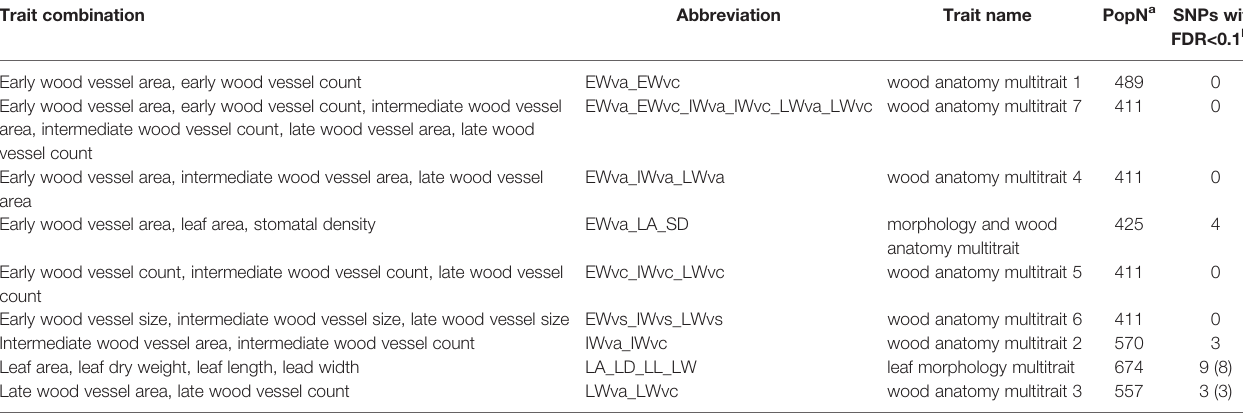
TABLE 2 | List of traits used for multitrait associations and signi fi cant SNPs identi fi ed in P. trichocarpa . Trait